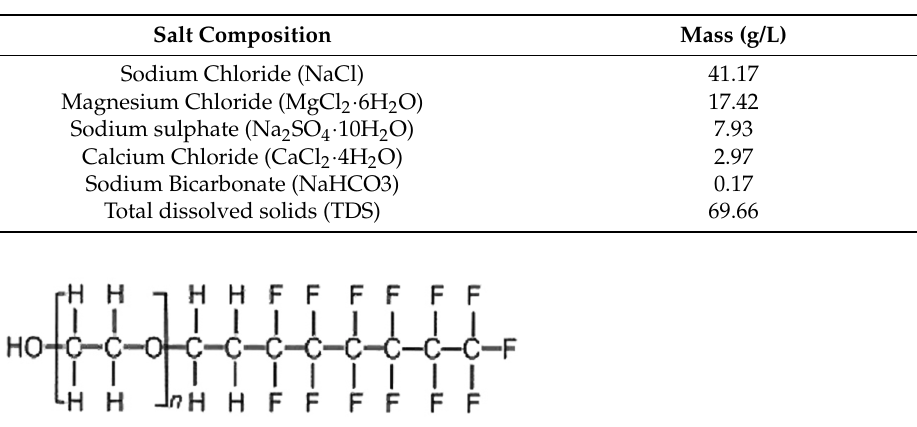
Figure 1. Chemical structure of the used surfactant.